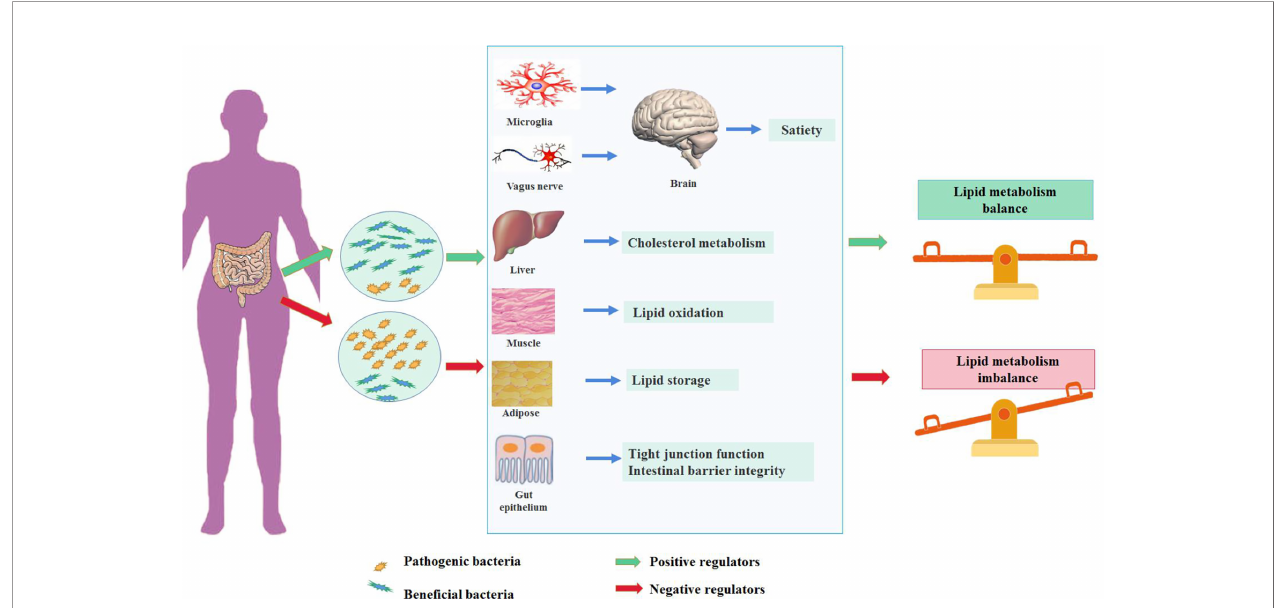
FIGURE 1 | The impact of gut microbiota in the development of